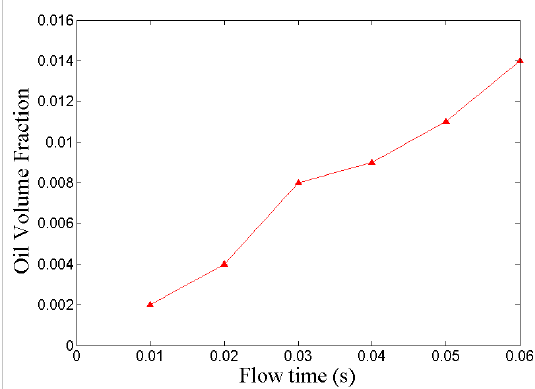
Figure 4. Oil volume fraction inside the bearing with flow time.